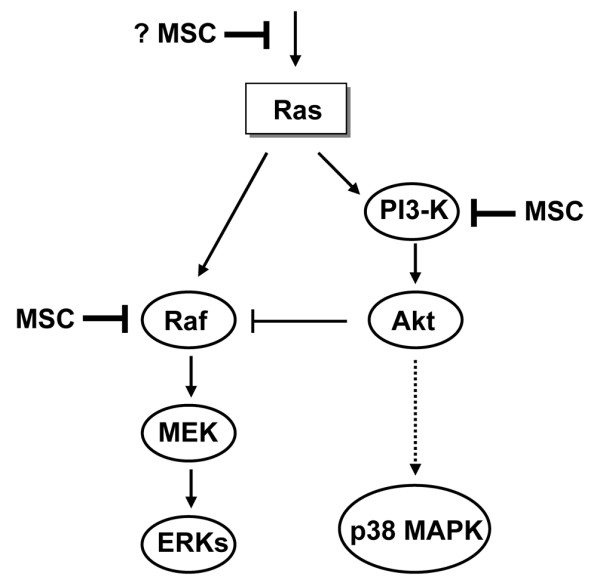
Possible sites of Se-methylselenocysteine (MSC) interaction with components of the Ras–phosphatidylinositol 3-kinase–Akt (Ras–PI3-K–Akt) and Raf–MAP kinase/ERK kinase–ERK (Raf–MEK–ERK) pathways in TM6 mouse mammary tumor cells. MAPK, mitogen-activated protein kinase.